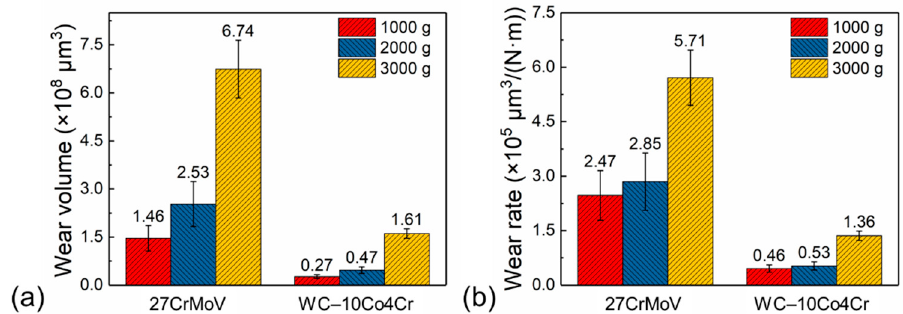
Figure 16. ( a ) Wear volumes and ( b ) wear rate of the 27CrMoV substrate and WC–10Co4Cr coating after friction tests at different loads.